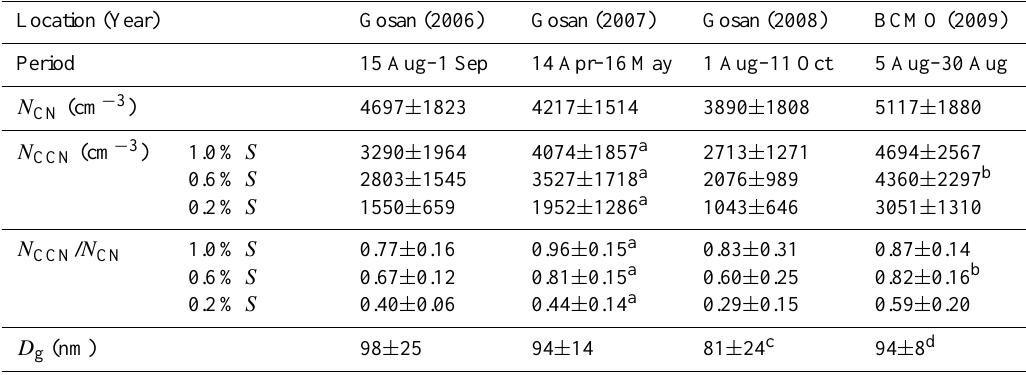
Table 1. Average and standard deviation of N CN , N CCN , N CCN / N CN , and D g for each campaign.